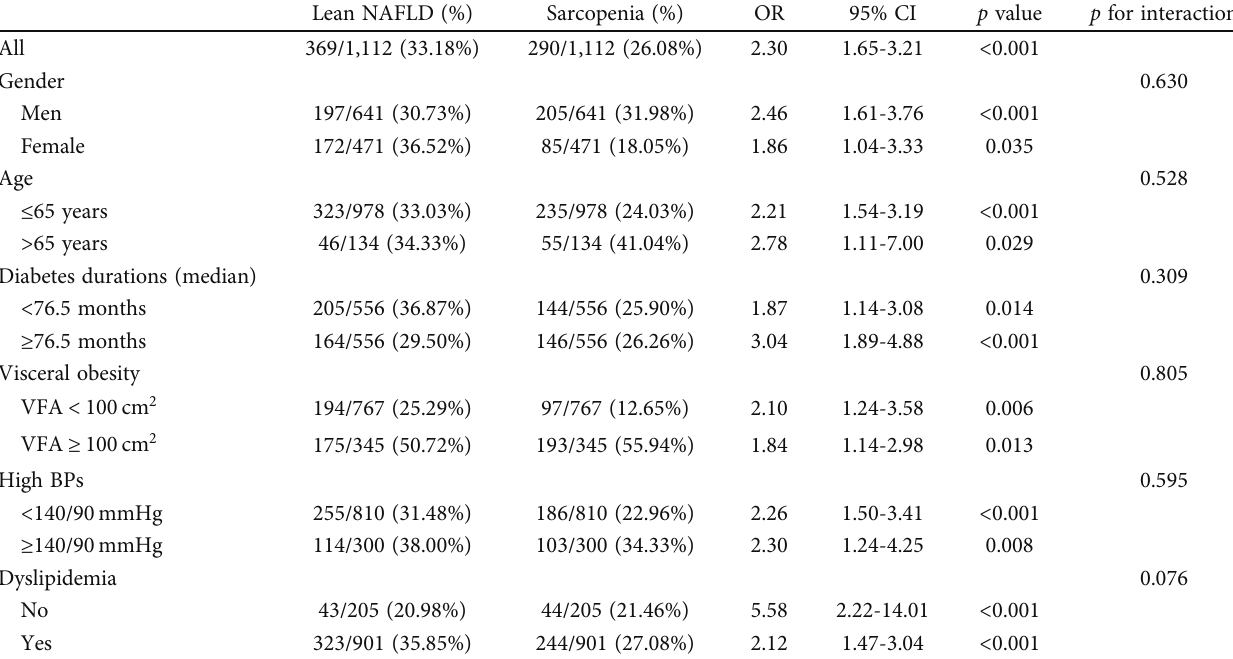
Table 3: Subgroup analysis between sarcopenia and prevalent lean nonalcoholic fatty liver disease in patients with type 2 diabetes mellitus. Lean NAFLD